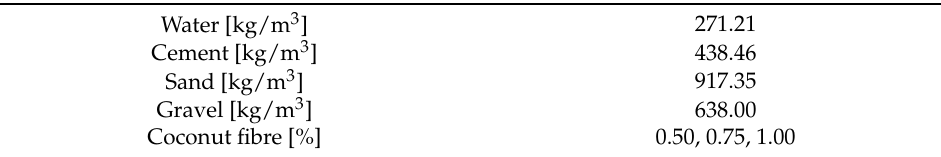
Table 4. Mix proportions of concrete.